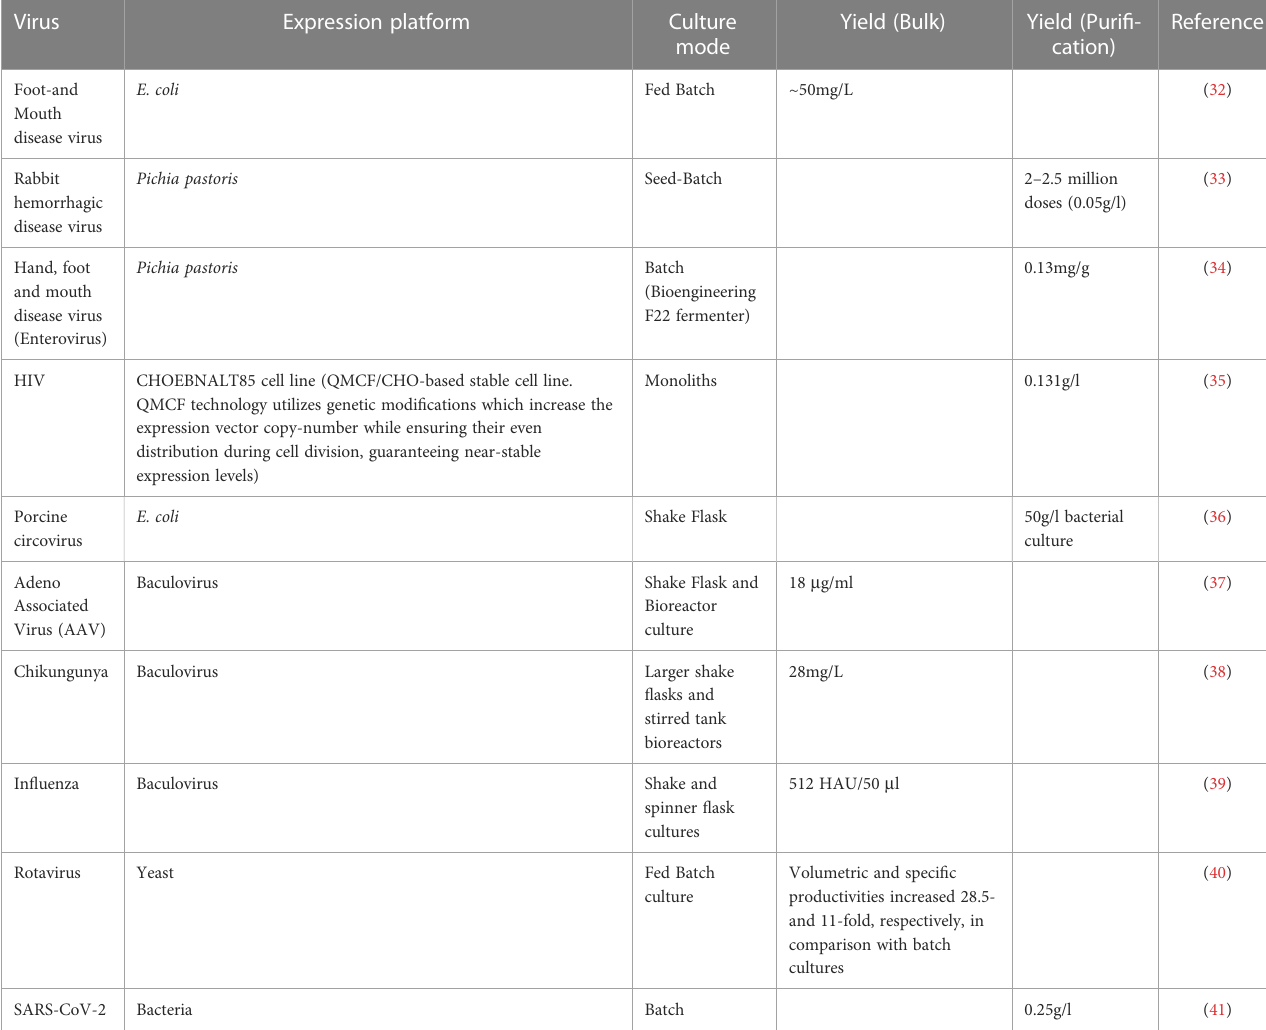
TABLE 2 Yield associated with the various culture modes using different VLP